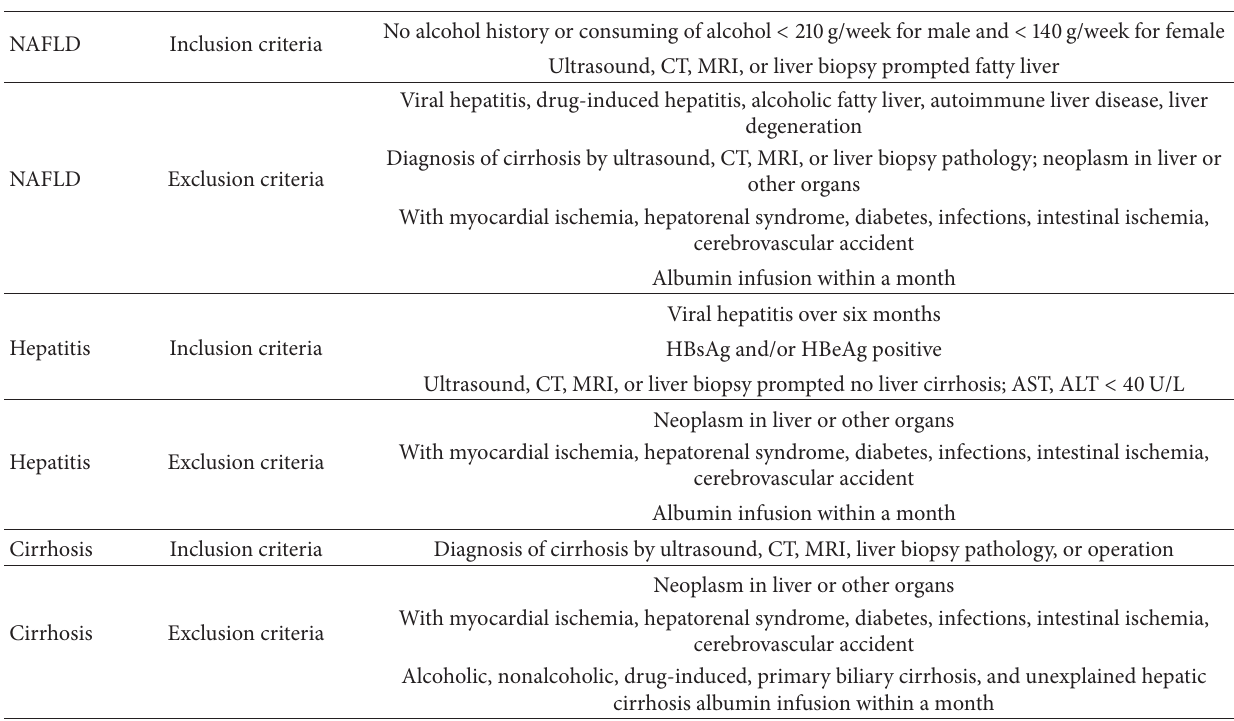
Table 1: Inclusion and exclusion criteria for NAFLD, hepatitis, and cirrhosis